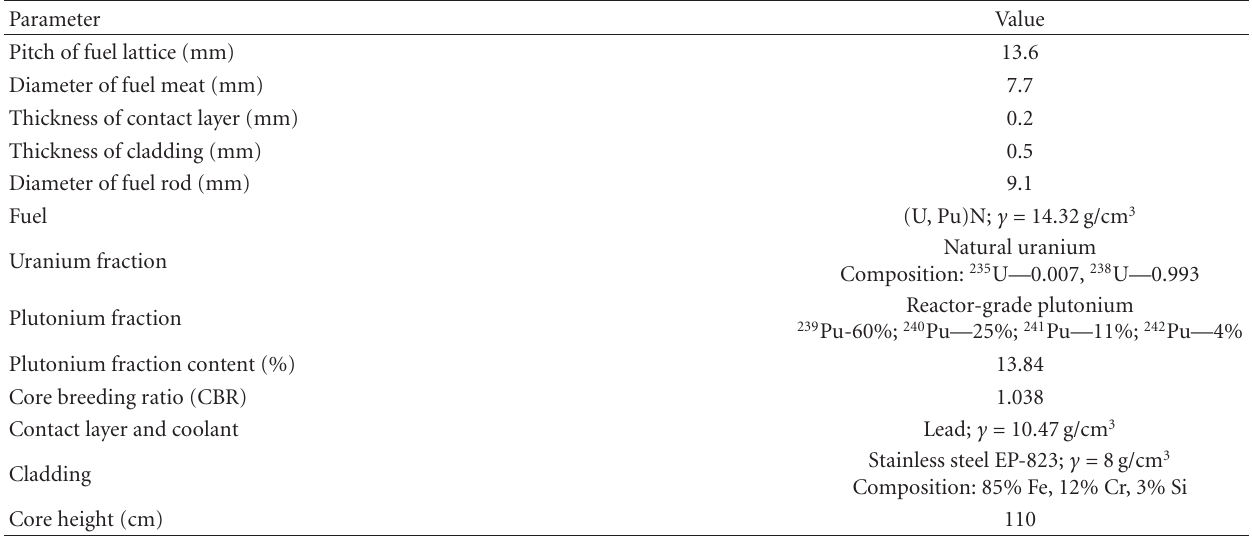
Table 3: Main parameters of the calculation model.